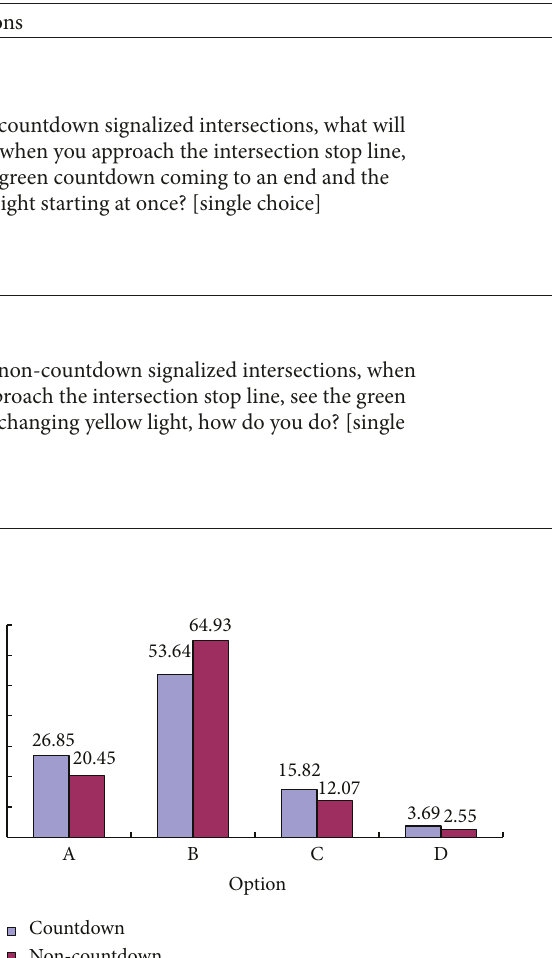
Table 4: Behaviors of surveyed drivers on the green signal coming to an end in the two cases.